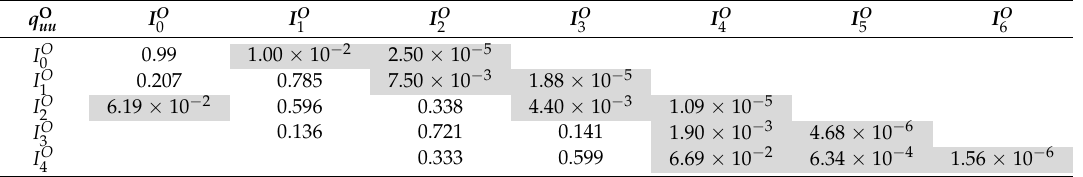
Table 1. Conditional probabilities q O uu of all possible transition in Nb-0.5V alloys. q O